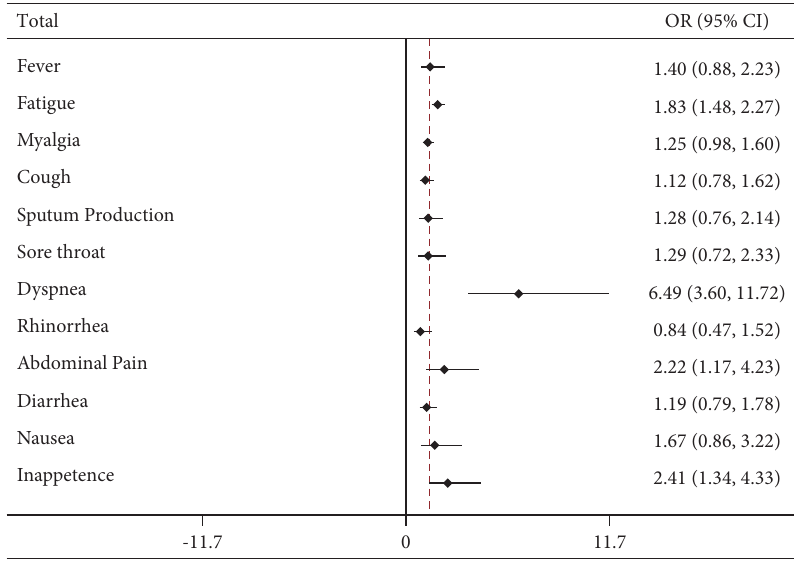
Figure 6: Clinical manifestations of mild and severe COVID-19